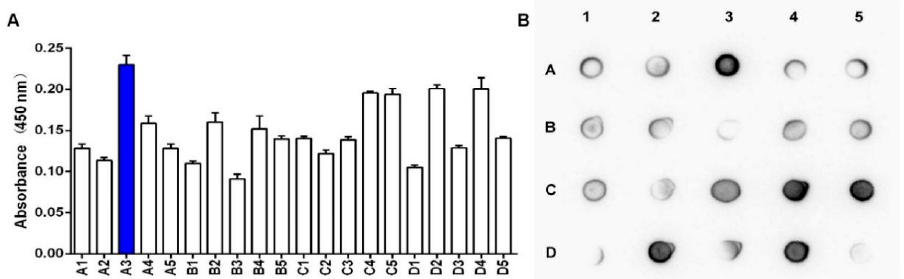
Figure 3. Analysis of relative expression levels of 20 positive clones. ( A ) Evaluation of the relative expression levels of various positive clones using ELISA. Recombinant BSDb relative expression levels were measured using the absorbance of 450 nm, clone A3 (blue column) possessed the highest production of the recombinant BsDb compared to the others. ( B ) Relative expression levels of BsDb in supernatants from twenty PCR positive clones were evaluated using spot Western blotting. The experiments were performed in triplicate, and the mean values ± standard deviation (SD) are presented. To improve the recombinant BsDb production, the optimal expression conditions of this recombinant BsDb were evaluated using spot Western analysis and ELISA. The results show that the maximum production level of this BsDb was achieved as approximately 20mg/L under the following conditions: methanol concentration, 1%; pH value, 4.0; inoculum density, OD600 = 4 and the induction time, 96 h (Figure 4).